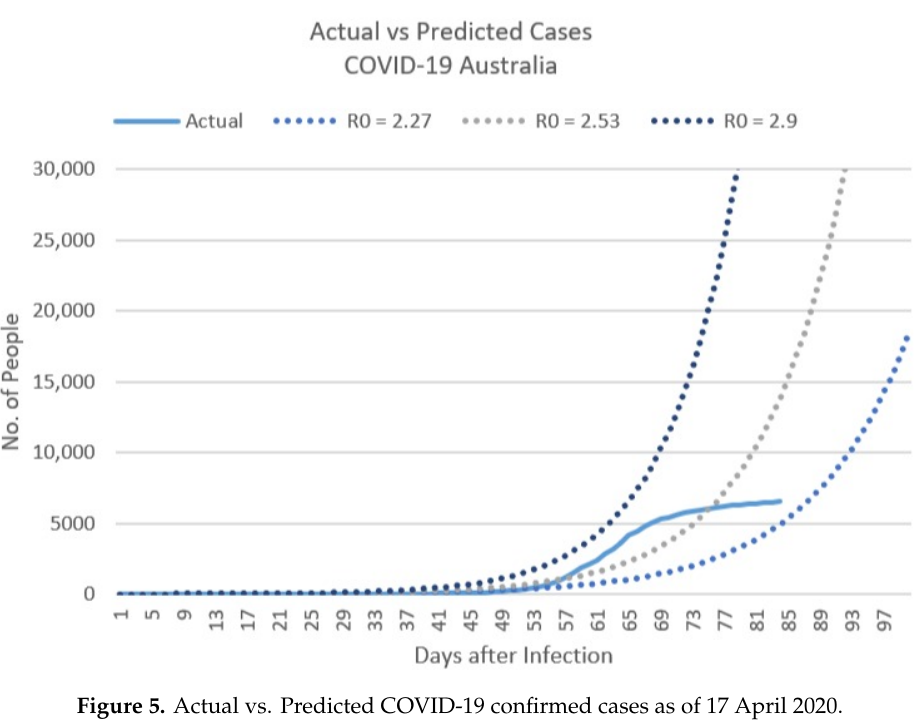
Figure 5. Actual vs. Predicted COVID-19 confirmed cases as of 17 April 2020 .